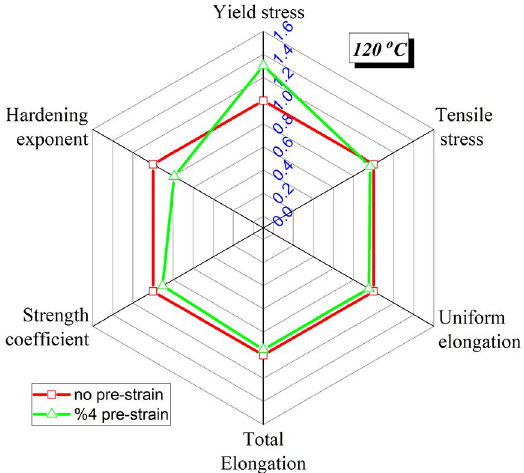
Figure 15. Comparison of mechanical properties at 120 ºC